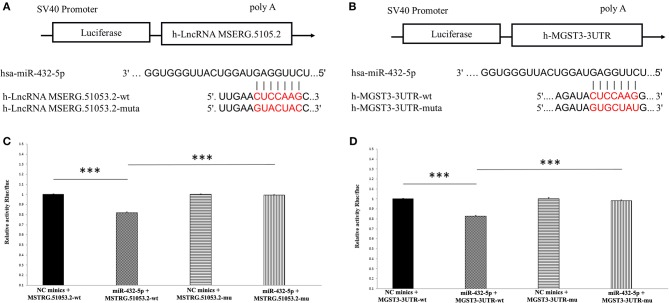
Representative fluorescent in situ hybridization (FISH) images in the blank group (blank) and the MSTRG.51053.2 and miR-432-5p co-transfection group (miR-432-5p mimic).